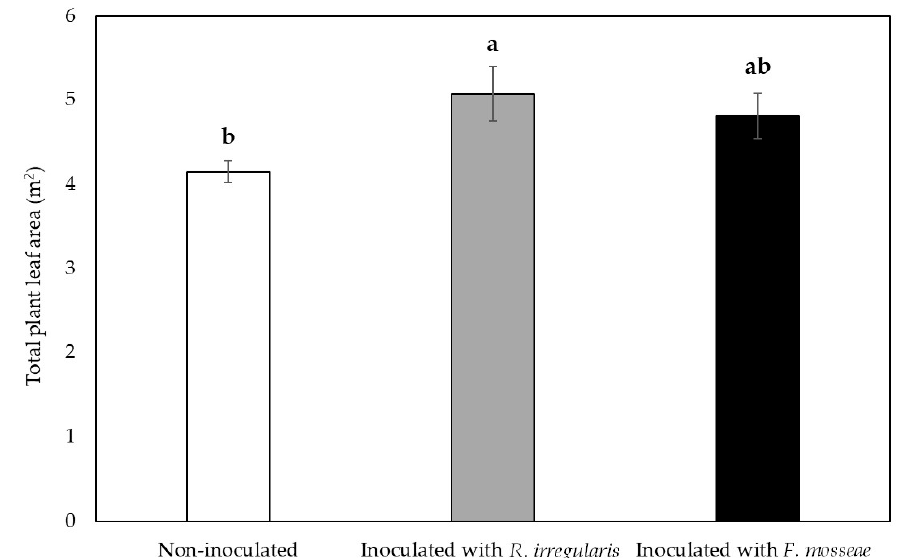
Figure 3. Total leaf area per plant in ‘Touriga Nacional’ variety vine plants grafted onto 1103 Paulsen rootstock. Bars indicate the average value ( n = 5) ± standard error. Di ff erent letters indicate significant di ff erences in group means according to Duncan’s a posteriori test. Significant e ff ect, p -value < 0.05.